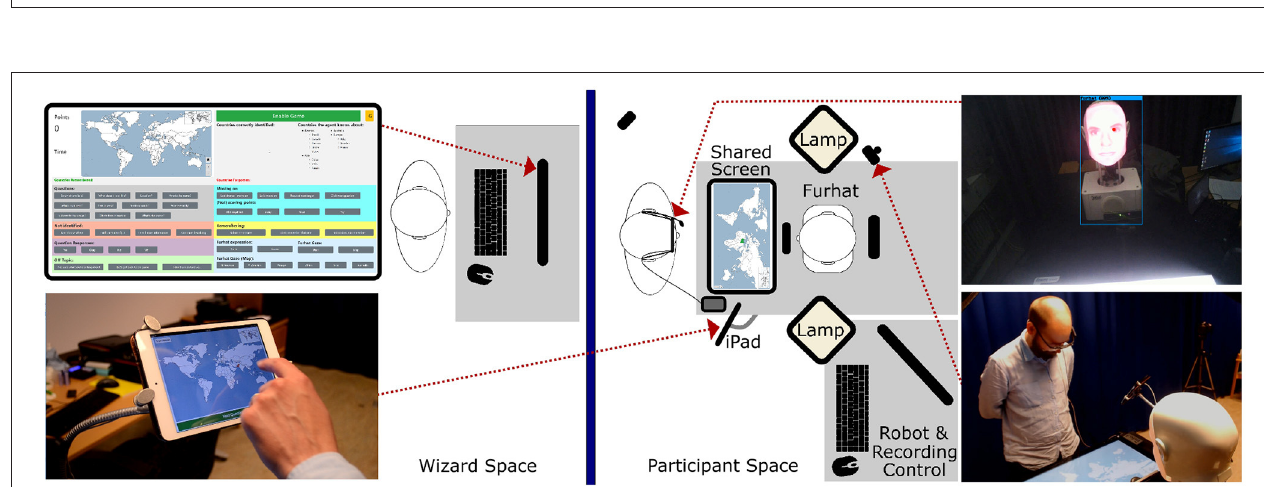
FIGURE 1 | The Furhat robot with the humanlike (left) , mechanical (right) , and morph (center) facial texture applied.